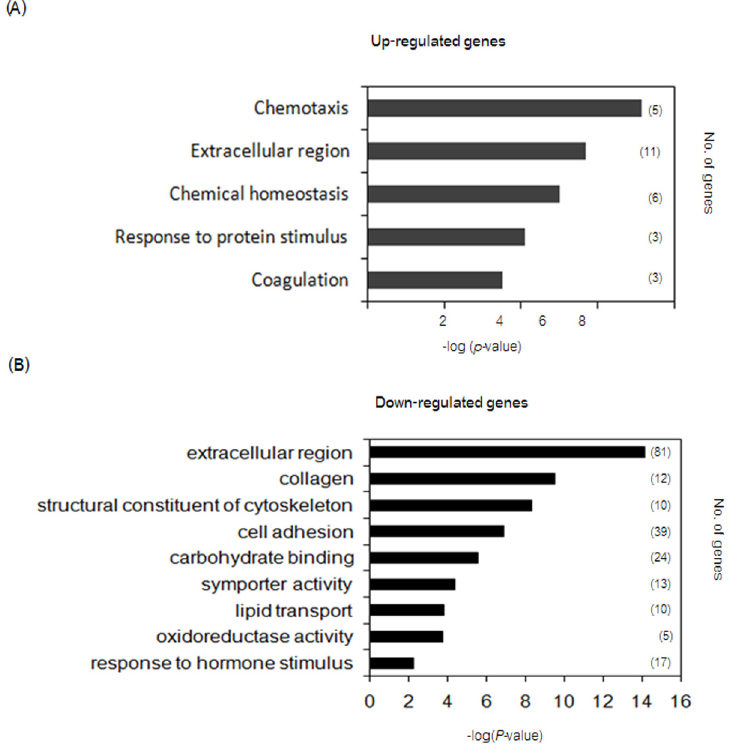
Fig 3. GO enrichment analysis. GO enrichment analysis was performed for the upregulated (A) and downregulated (B) DEGs. The x axis indicates the significance of DEGs as − log ( p value). The number of genes in each category is shown on the y axis, as indicated in parentheses.